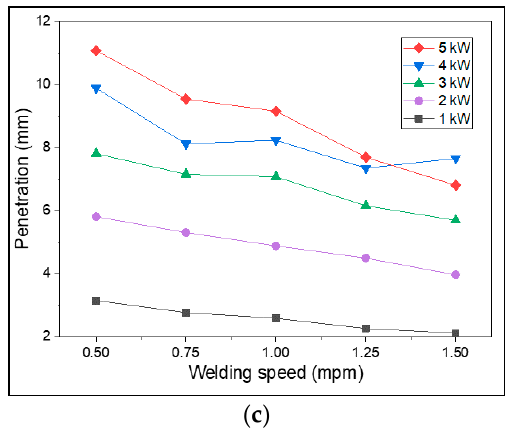
Figure 10. Bead shape according to welding speed: ( a ) bead width ( b ) height ( c ) penetration.